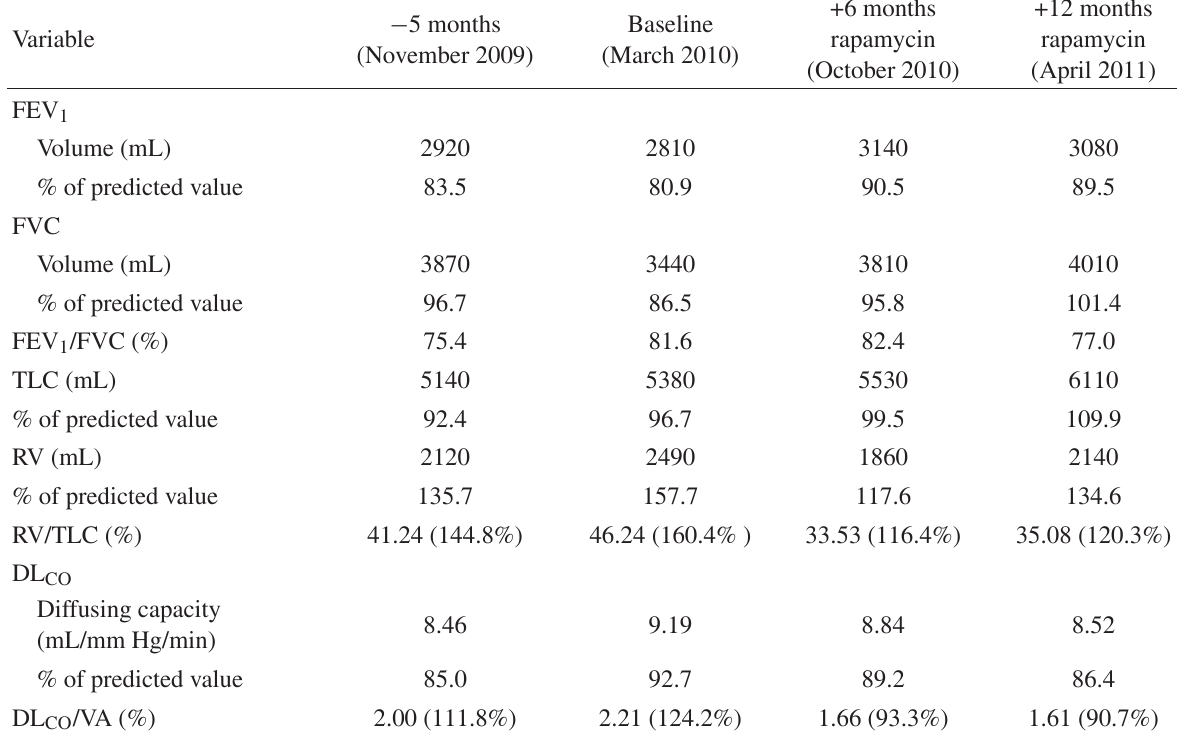
TABLE 1: Effect of rapamycin on pulmonary function in a patient with LAM treated for 12 months. Variable